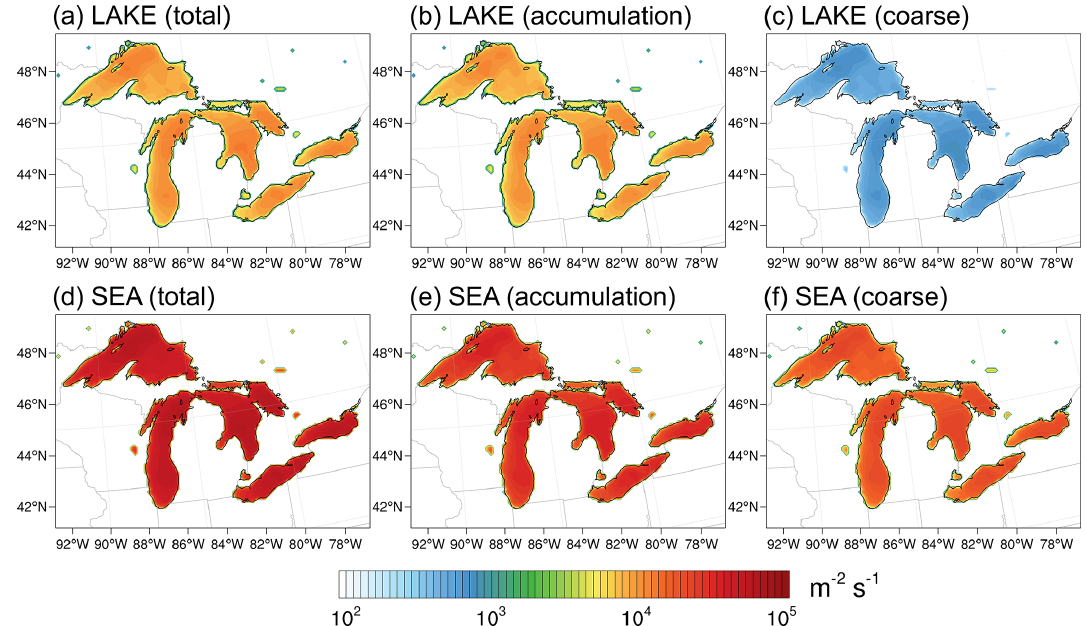
Figure 7. Average (10–30 November 2016) (a, d) total, (b, e) accumulation-mode, and (c, f) coarse-mode aerosol number emission flux in the LAKE and SEA